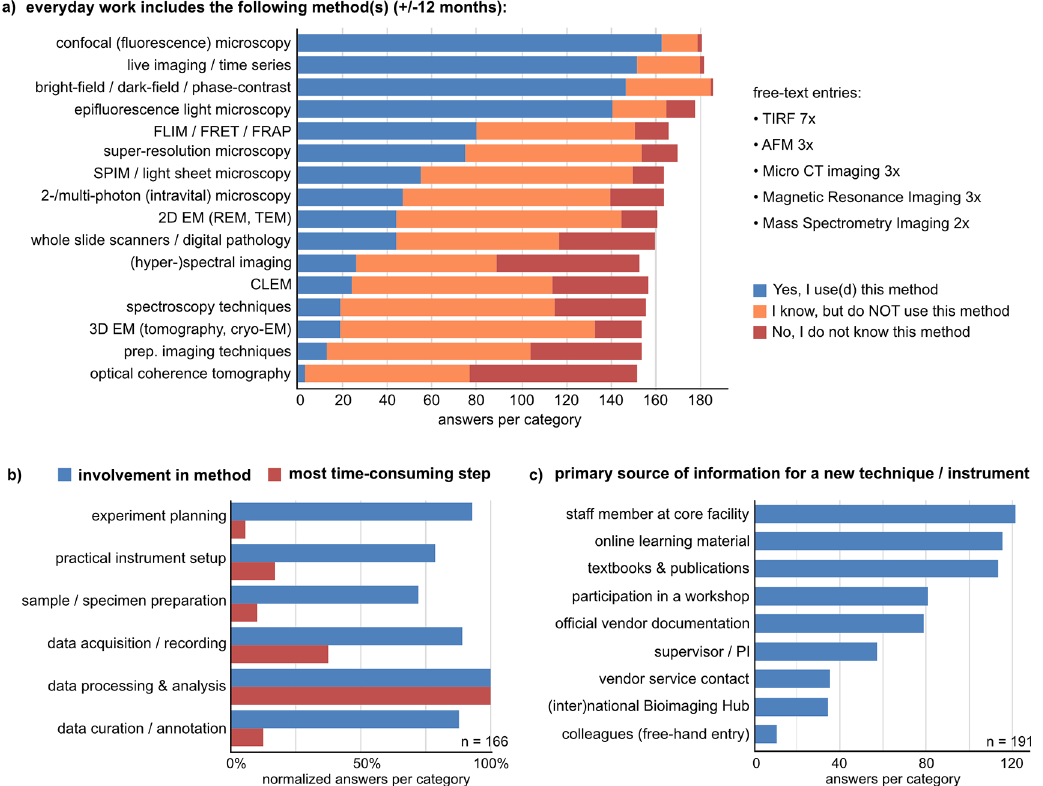
Figure2.Knowledgeanduseofbioimagingmethods. a)Participantswereaskedtostate,iftheirworkincludesthe indicated methods ( (cid:1) 12 months) with a preselected list and a free-text option. This question was shown to respondents who stated “ I use bioimaging or biophotonics methods ” or "I am not sure, if one of my methods is a bioimaging or biophotonics method ” , incl. one person who left the field blank (Figure 1e, n = 188). b)